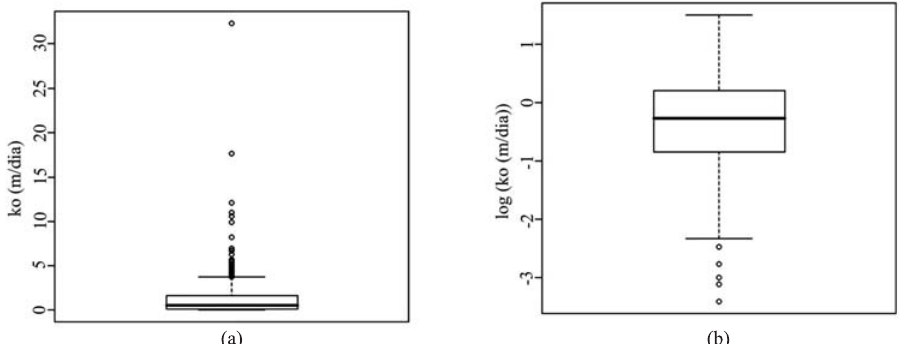
Figura 3. Gráficos “boxplot” de dados sem (a) e com transformação logarítmica